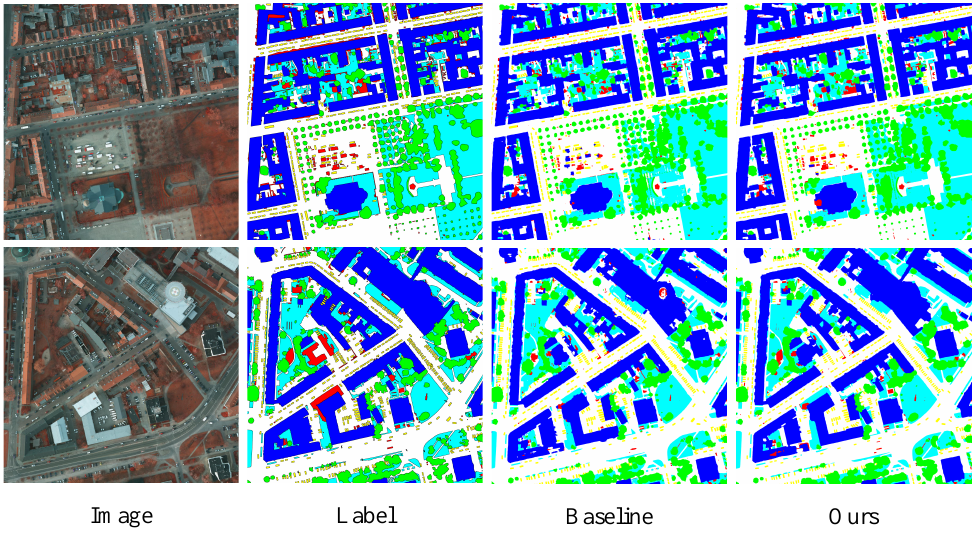
Figure 9. Visualization of the prediction results of the proposed method and the baseline model (FCN) on the original large images of the Potsdam